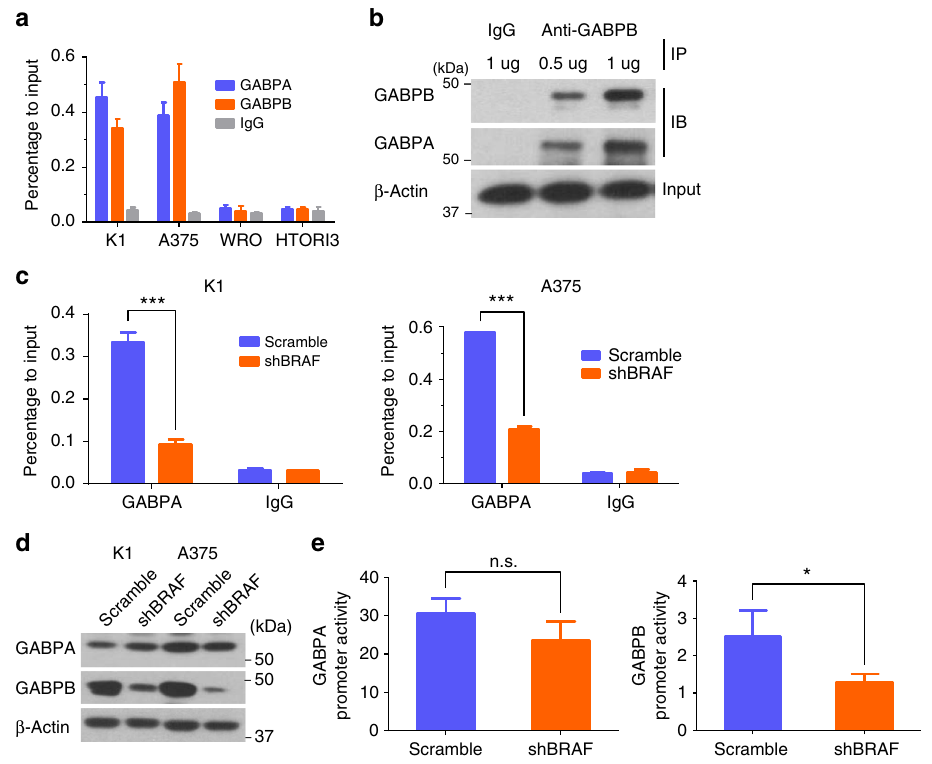
Fig. 4 BRAF V600E promoted GABP binding to mutant TERT promoter by upregulating GABPB . a Chromatin-immunoprecipitation (ChIP) assay for GABPA and GABPB occupancy at TERT promoter in K1 and A375 cells with TERT promoter mutation and in WRO and HTORI3 cells without promoter mutation. IgG was used as negative control. b Co-immunoprecipitation (Co-IP) analysis of the interaction of GABPA with GABPB in K1 cells. c ChIP assay for GABPA occupancy at TERT promoter in K1 and A375 cells with or without stable BRAF knockdown. d Western blotting analyses of GABPA, GABPB, and beta-actin in K1 and A375 cells with/without stable BRAF knockdown. e Luciferase reporter assays for GABPA and GABPB promoters in A375 cells with or without stable BRAF knockdown. Scramble shRNA was used as control. * P < 0.05, *** P < 0.001, by two-tailed Student ’ s t test. n.s. not signi fi cant. All the values represent the average ± standard deviation (SD) of triplicate samples and similar results were obtained in at least two independent